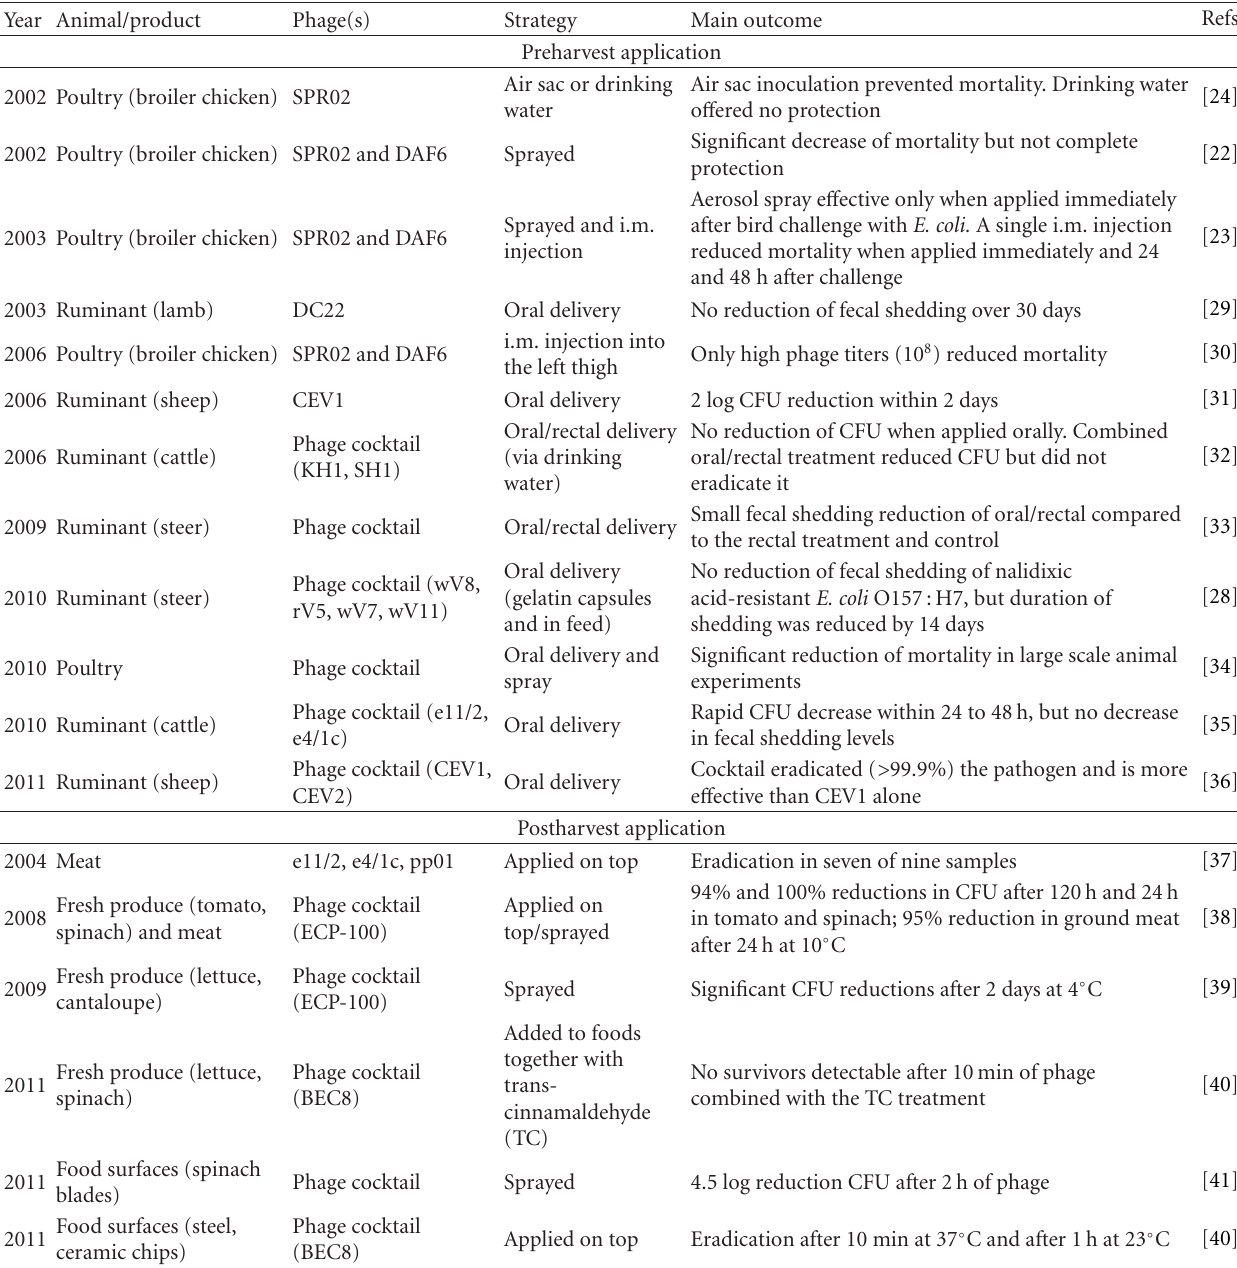
Table 1: Pre- and postharvest E. coli O157 :H7 phage